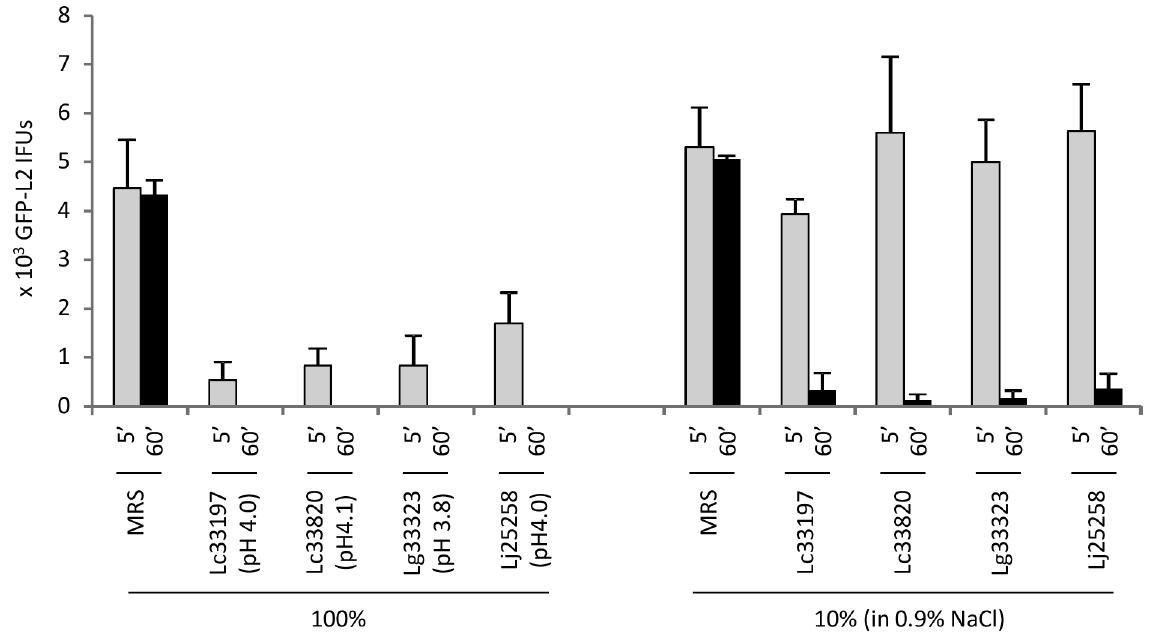
Figure 1. Time- and concentration-dependent inactivation of elementary bodies (EBs) of GFP-L2, derived from C.trachomatis serovar L2, by Lactobacillus- conditioned medium (LCM). LCM was collected from overnight still cultures of L. crispatus 33197 (Lc33197), L. crispatus 33820 (Lc33820), L. gasseri 33323 (Lg33323) and L. jensenii 25258 (Lj25258). pH values of undiluted (100%) LCM are shown. EBs were treated with undiluted LCM or LCM diluted 10 fold with 0.9% NaCl for 5 min or 1 h. Following treatments, surviving EBs were serially diluted and then inoculated onto McCoy monolayers; resulting inclusion-forming units were scored by fluorescence microscopy. Values were averages 6 standard deviations of triplicate